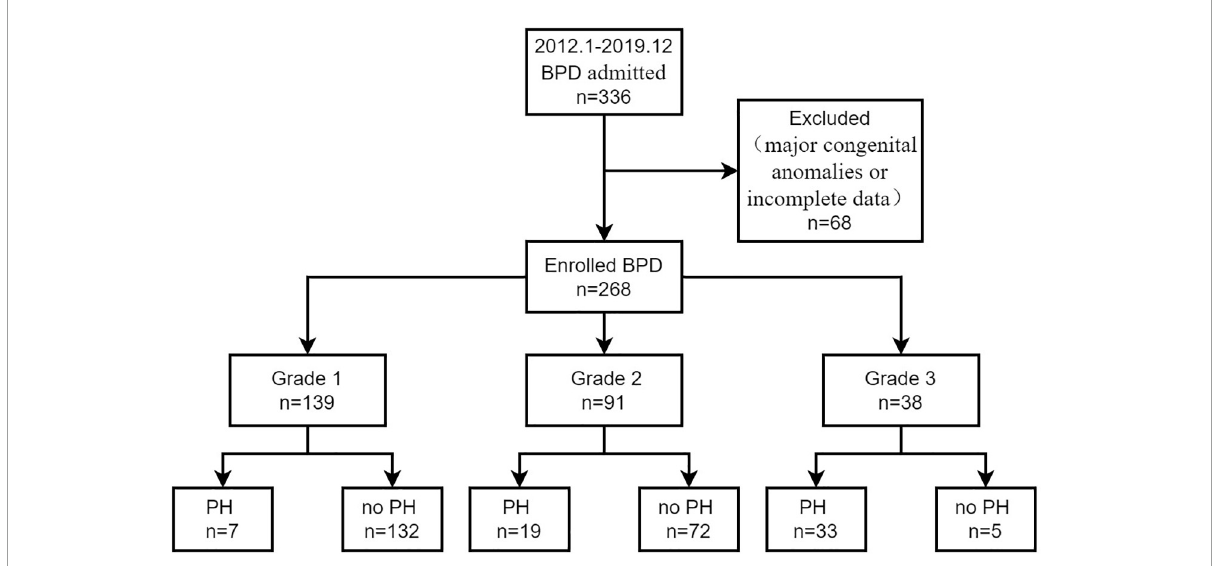
FIGURE1 A flow diagram of study participants. BPD, bronchopulmonary dysplasia, PH, pulmonary